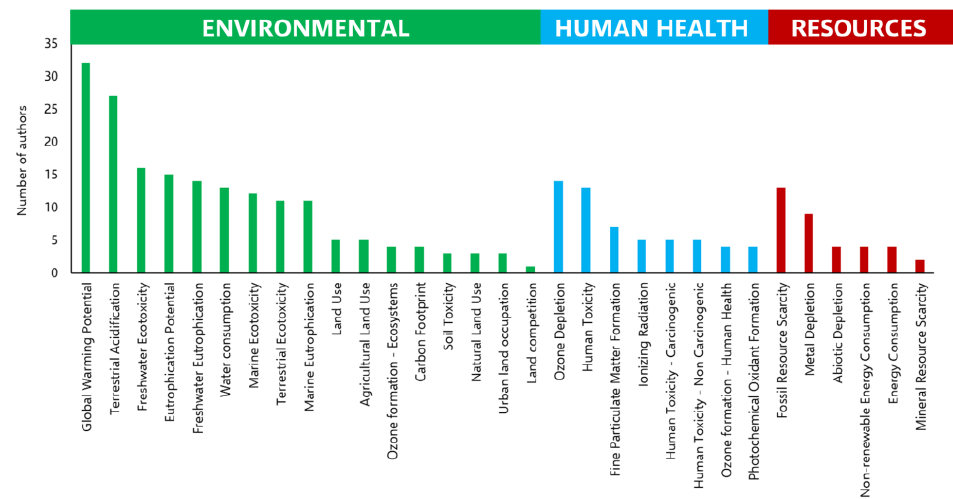
Figure 4. Most used impact categories in LCA studies – Rice.